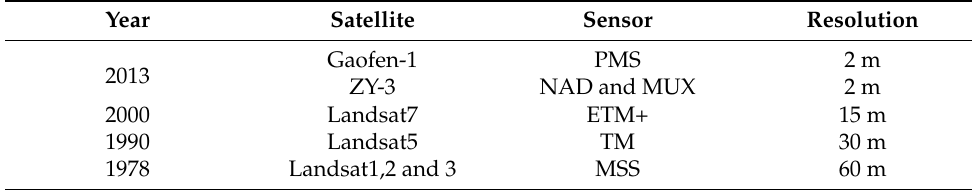
Table 2. The images used in the historical data